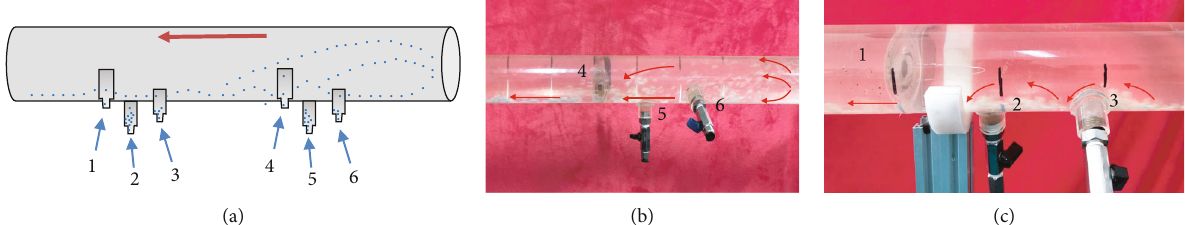
Figure 3: The migration trajectory of particles in the 3mm temporary plugging agent wellbore; (a) schematic diagram of the particle migration; (b) particle migration trajectory at C1; (c) particle migration trajectory at C2. . . . .